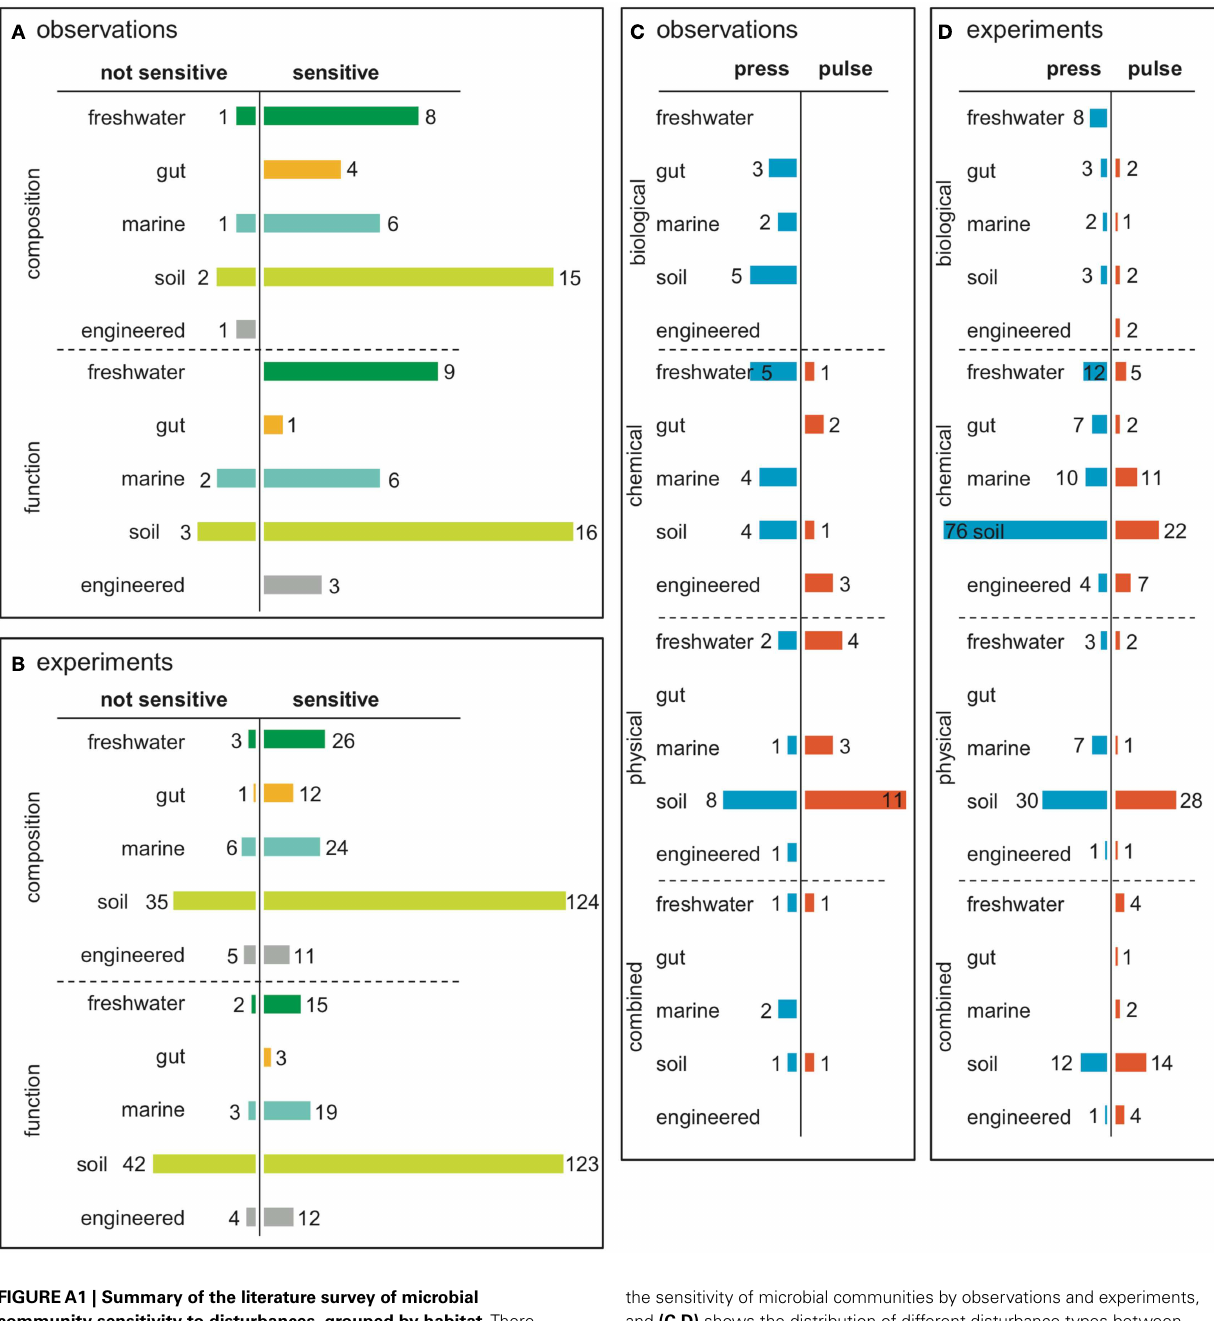
FIGUREA1 | Summary of the literature survey of microbial community sensitivity to disturbances, grouped by habitat. There were 378 total investigations gleaned from 247 total studies, as some studies investigated more than one disturbance or measured more than one function. Note that a few studies that considered uncommonly investigated habitats (one wetland, two sediment, six culture-based, and one leaf/detritus) are not shown in this figure. Investigations were classified as either (A–C) observations or (B–D) experiments. (A,B) shows